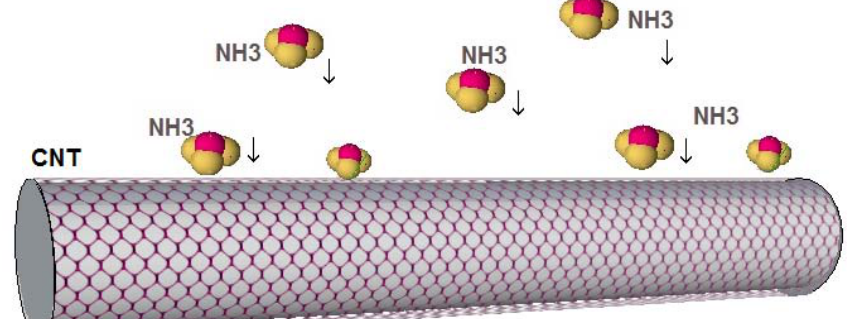
molecules acting as electron donors to the 3